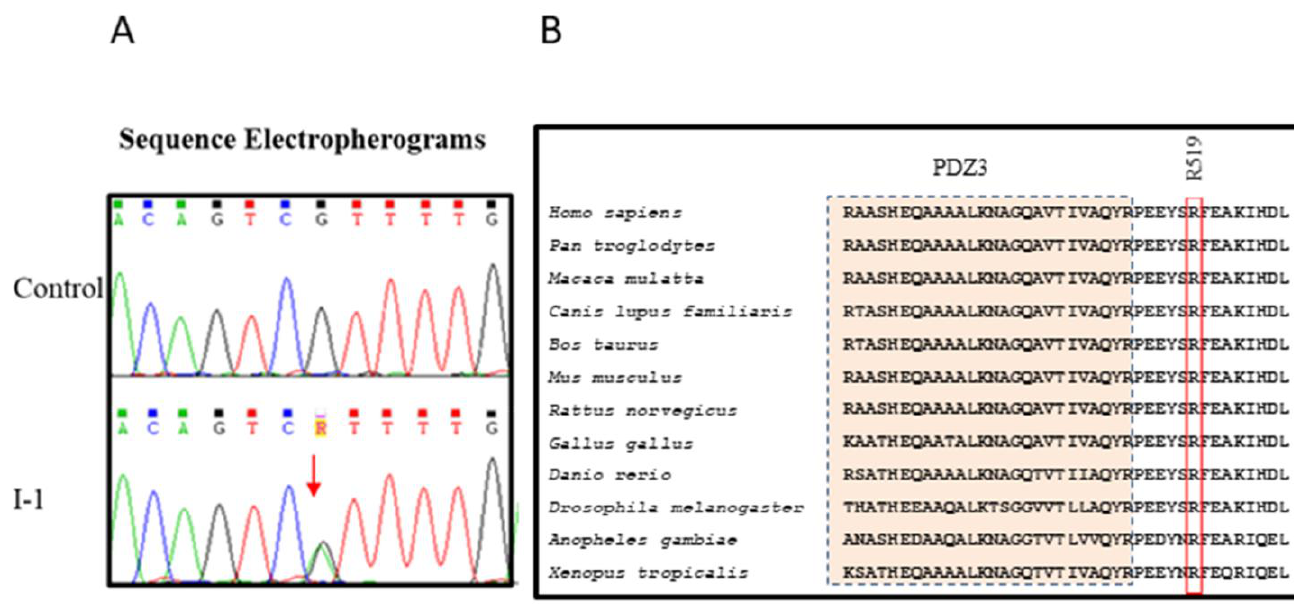
Figure 2. ( A ) Sanger sequencing showing the c.1556G>A substitution in the propositus. ( B ) Alignment of a portion of the PDZ3 domain and the amino acid position #519 (highlighted in red) along different species.